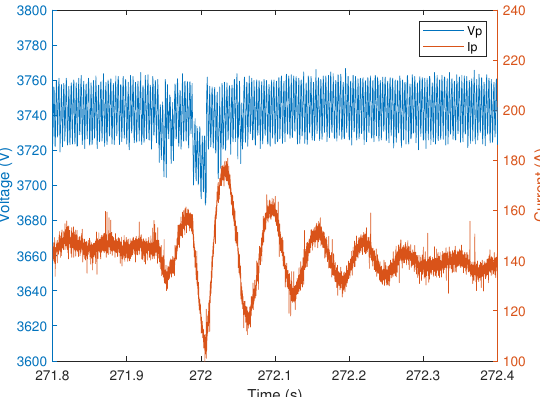
Figure 6. Time domain representation of V p and I p during arc event